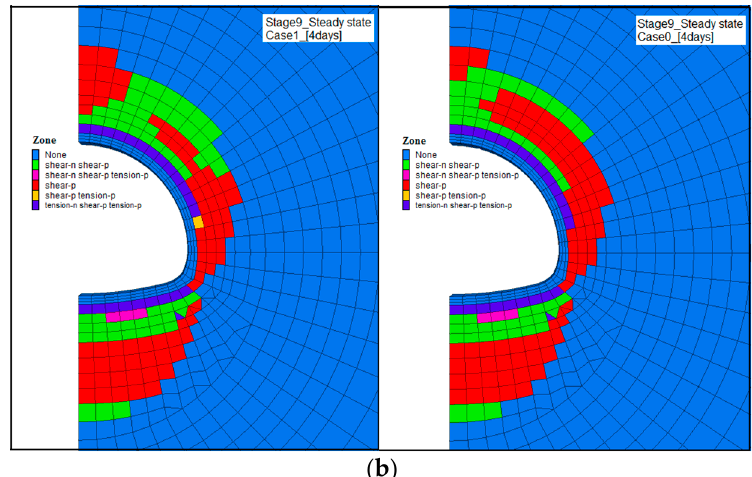
Figure 8. Failure zones comparison from stage 7 to stage 9. ( a ) Failure zones in stage 7; ( b ) Failure zones in stage 9.